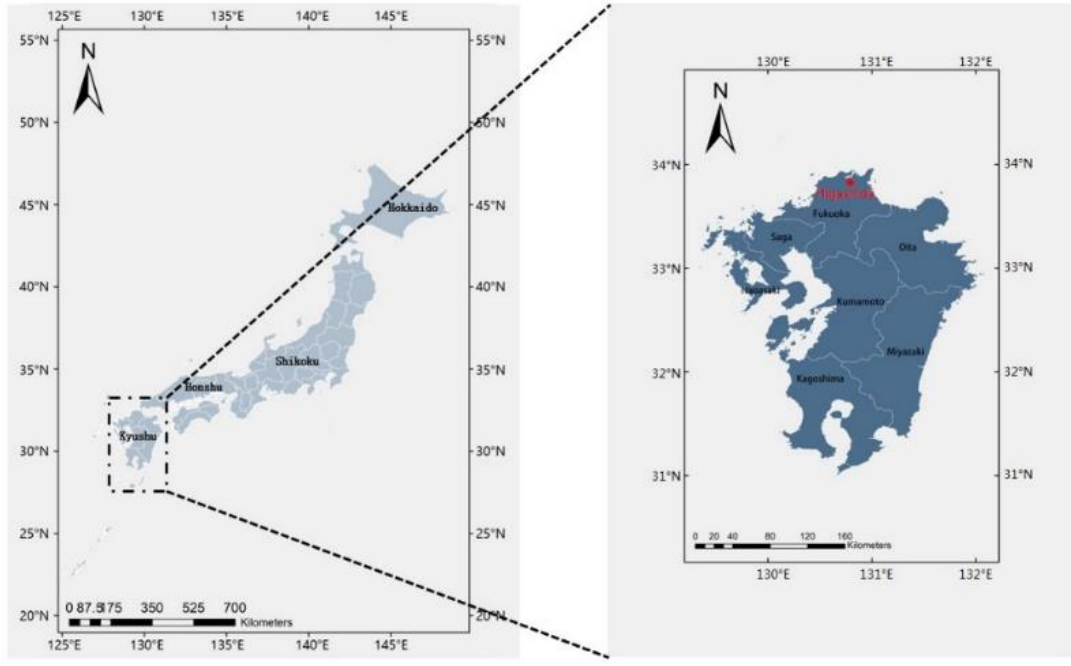
Figure 1. Location of Higashida region in